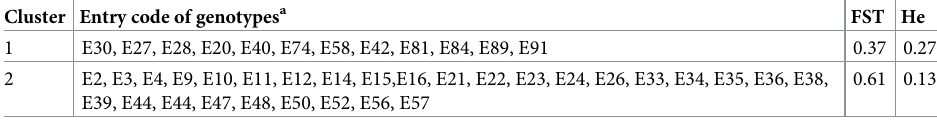
Table 8. Clustering of 60 common bean genotypes based on 16,565 SNP markers. Cluster Entry code of genotypes